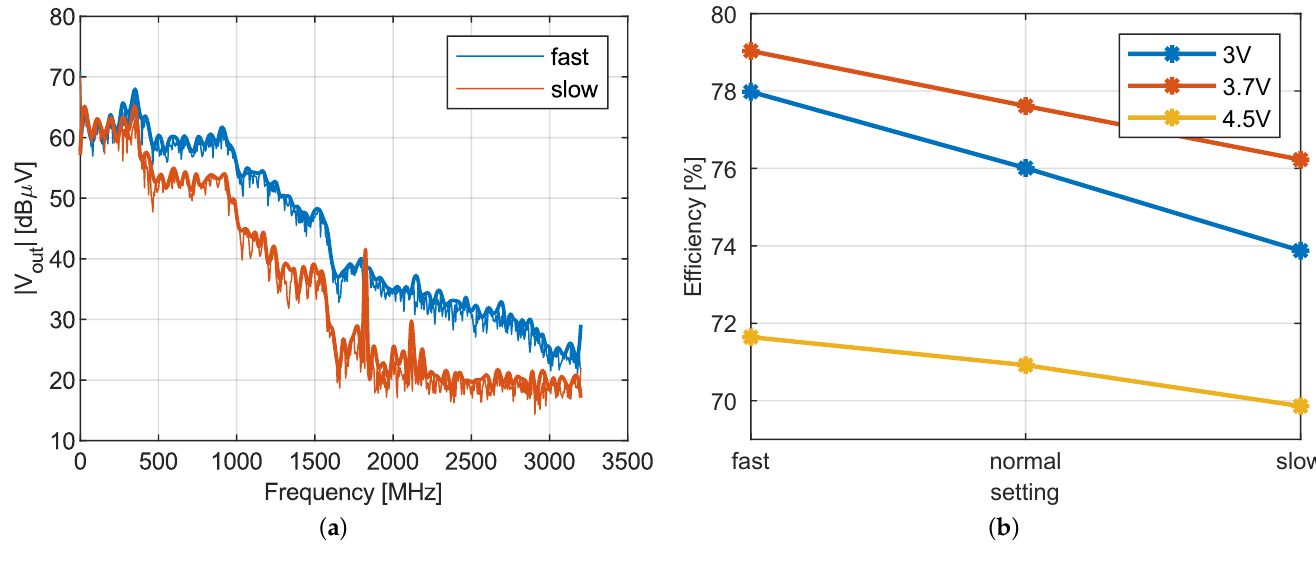
Figure 16. ADP5075: Ringing frequencies depending on the parasitic capacitance of the diode and the MOSFET. ( a ) ADP5075: Frequency spectrum on the output port at different slew rate settings; ( b ) ADP5075:Efficiency dependent on the slew rate and input